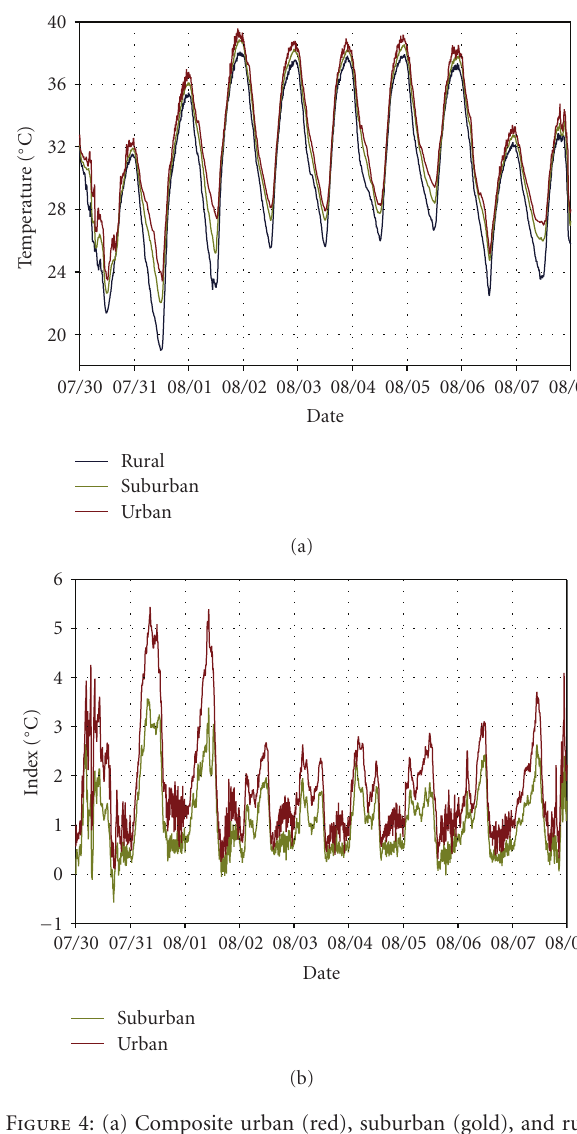
Figure 4: (a) Composite urban (red), suburban (gold), and rural (blue) values of computed heat index [48, 49] from 30 July 2008 to 8 August 2008. (b) Composite diurnal values of UHI Heat Index with respect to rural composite values for the urban (red) and suburban (gold) locations. The methodology is consistent with the analysis demonstrated in Figure 2(b) and computed values of the heat index [48,